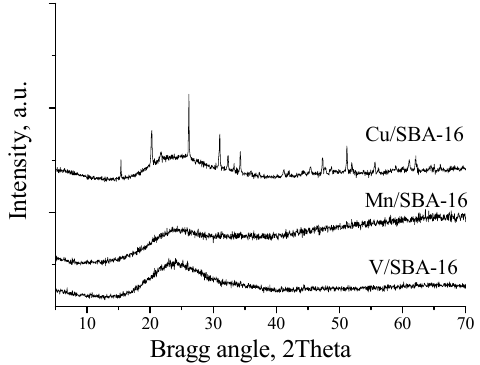
Table 3. Textural properties of the studied SBA-16 samples.